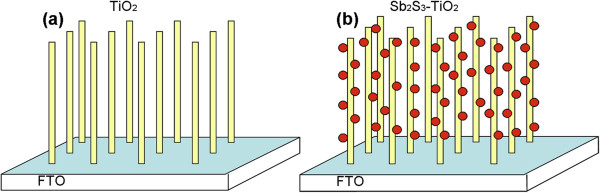
Schematic of (a) bare TiO2 nanorod arrays on FTO and (b) Sb2S3-TiO2 nanostructure on FTO.